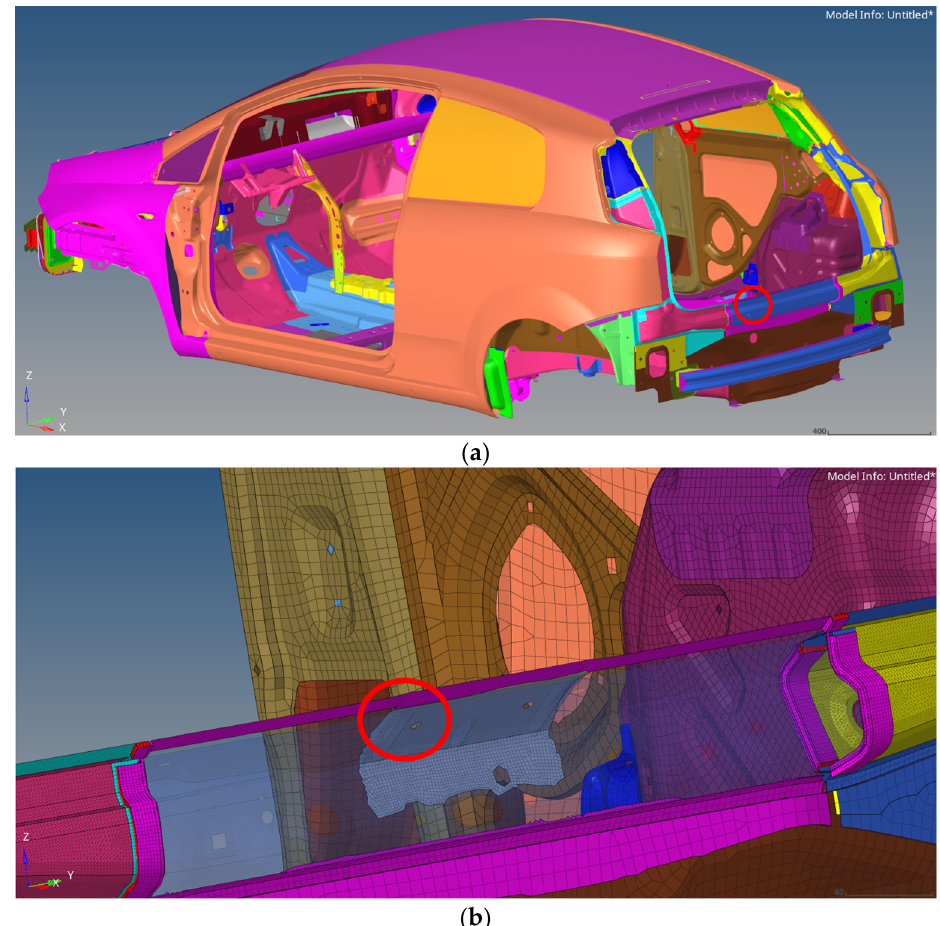
Figure 21. Left lock connection of the door hinge ( a ) with related close-up ( b ). Running a static and a dynamic stiffness analysis, namely, applying a force along z direction (yellow arrows in Figures 22a and 23a) at the two aforementioned points (Figures 22a and 23a), first statically and then dynamically, the corresponding static (Figures 22b and 23b) and dynamic (Figures 22c and 23c) stiffnesses were recorded.